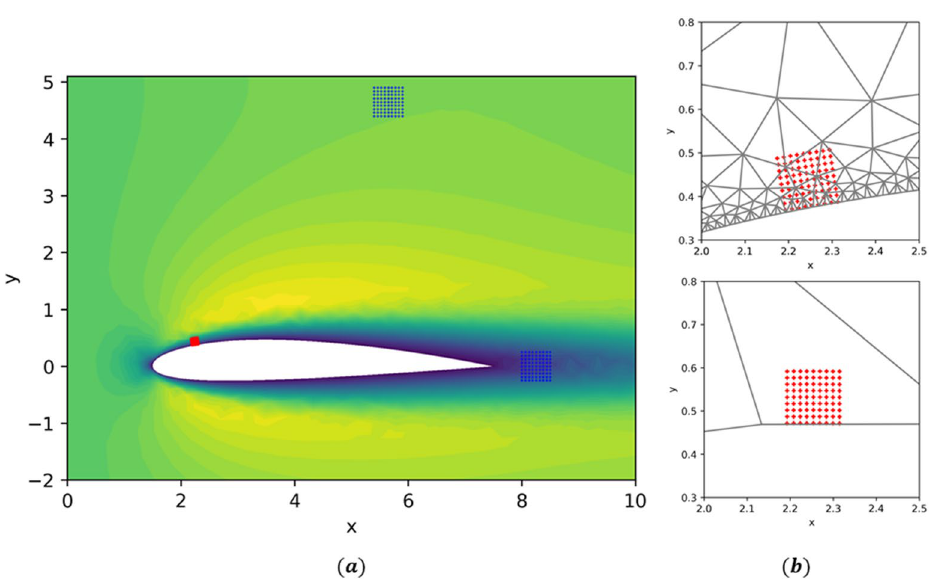
Figure 7. ( a ) Simulation results for the flow over a NACA 2412 airfoil at Re = 480 . Two sample grids were placed in the freestream and one on the top surface of the airfoil. ( b ) A closer view of the sample grid on the top surface of the